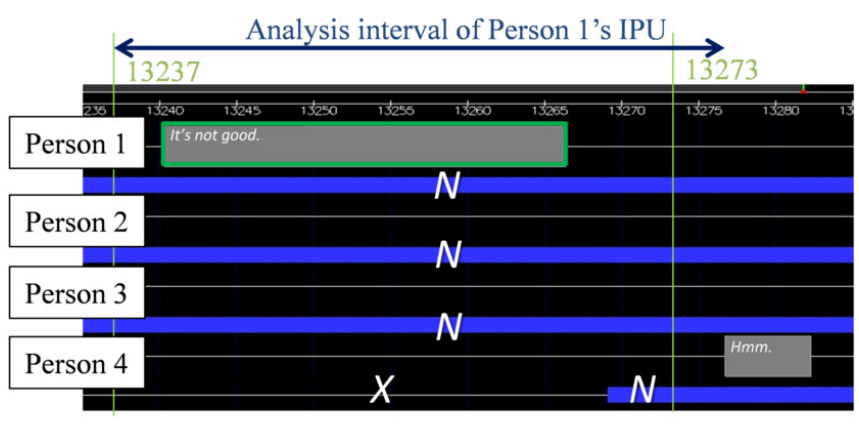
Figure 11. Second sample situation where turn-changing occurs from Person 1 to Person 4. Upper gray boxes show IPUs and lower boxes show the degrees of mouth-opening for each person along the